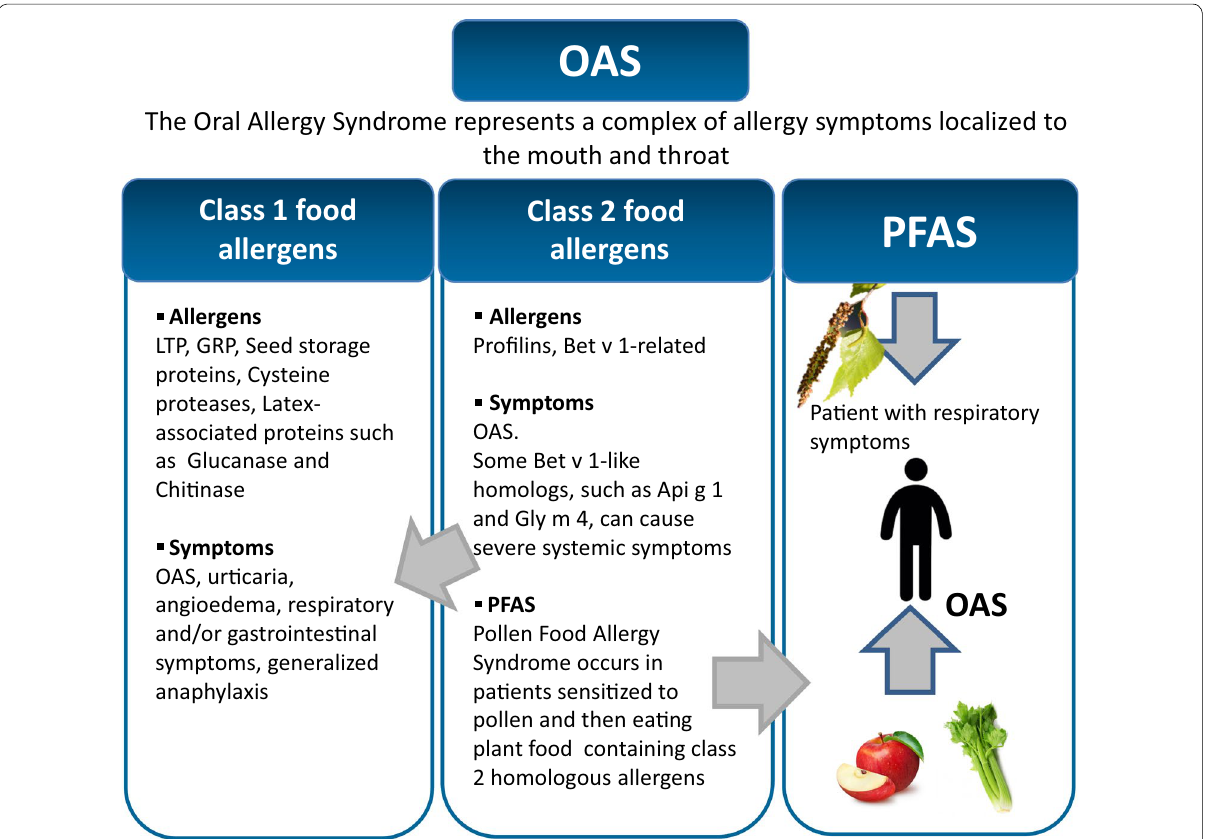
Fig. 1 Overview of the relationships between OAS, PFAS, class 1 and class 2 food